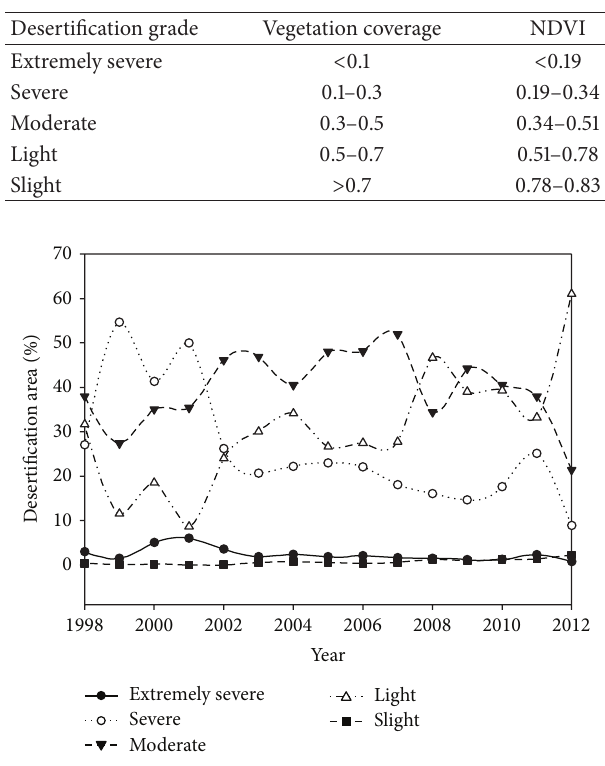
Figure 3: The proportional changes of land area for the different types of desertification on the northern Loess Plateau from 1998 to